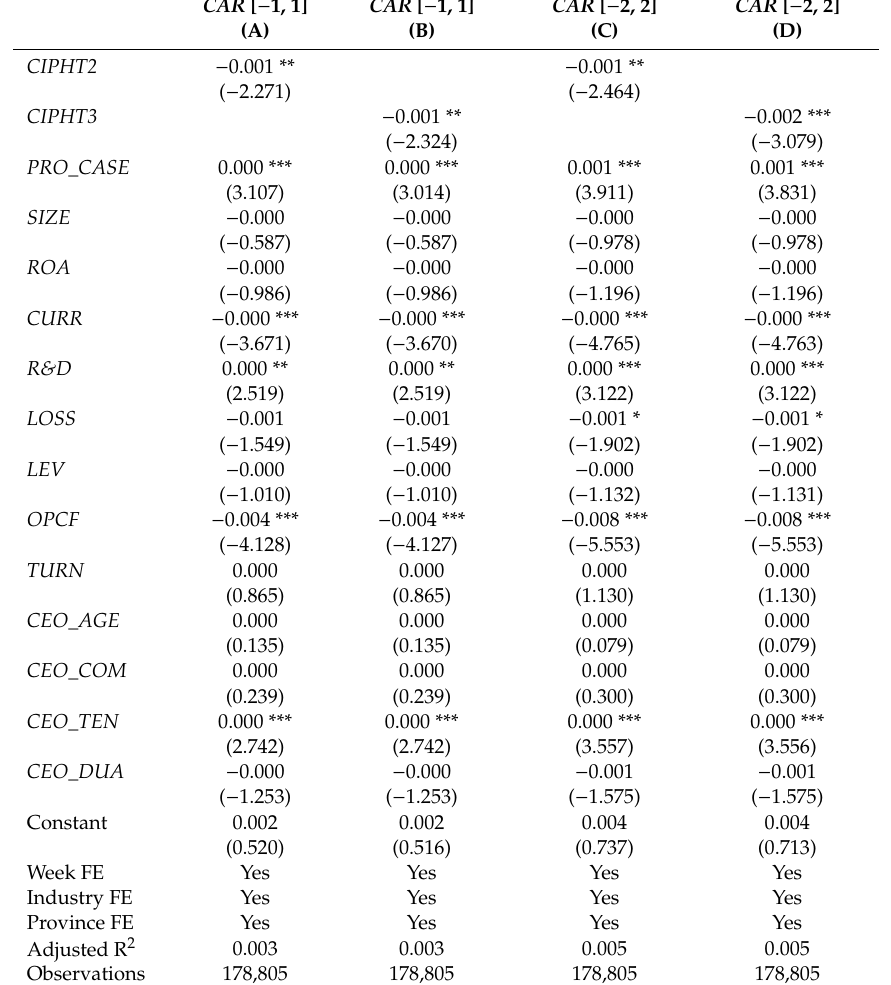
Table 5. Alternative measures of continued increasing public health threats and accumulative abnormal